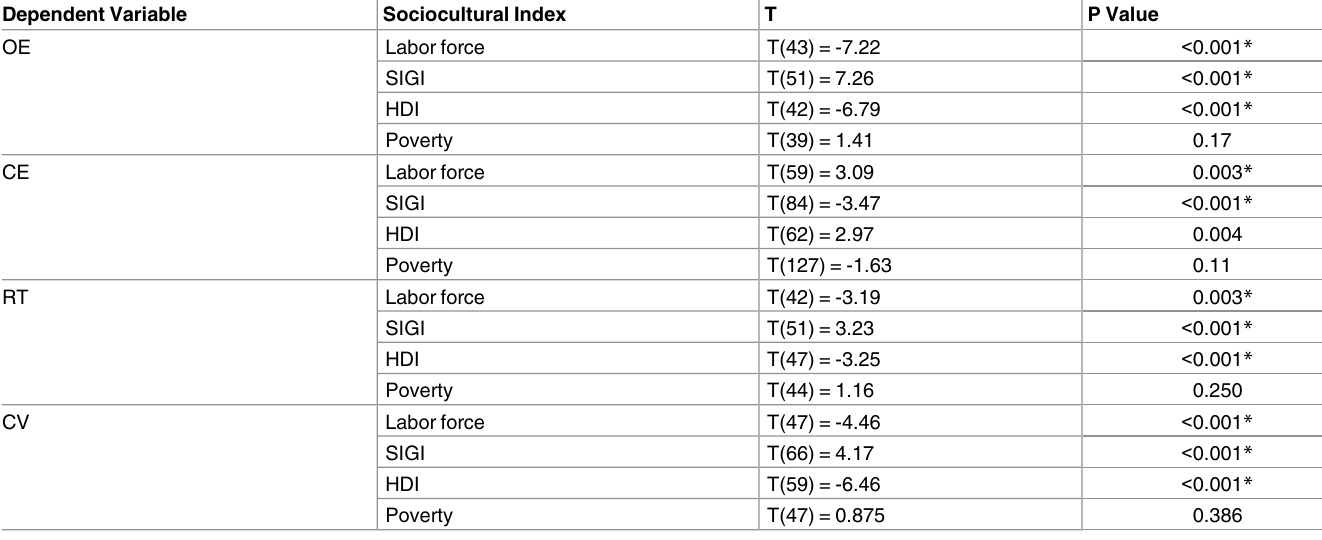
errors. Gender inequality accounted for a 1–2.5% change in error rates. Correlation analyses using socioculturalindices. To further confirm that the sociocul- tural indices were correlated with the size of gender difference, we performed Pearson’s corre- lation analysis between the average gender difference in each country and each of the 4 indices. For these analyses we excluded a single country from which fewer than 20 women participated (total countries = 40, total N = 16,552). For CV and reaction time we found no significant cor- relation between the magnitude of gender difference and any indices of social conditions (all |r| < 0.35). However, consistent with the mixed model analysis above, for commission and omis- sion errors we found significant correlations (using the Bonferroni correction) between gender difference and indices of gender equality (Table 5, Fig 3). Specifically, we found that in condi- tions of lower gender equality, men made more commission errors and women made more omission errors, but as gender equality increased, men and women performed more similarly on both measures. These results, using country averages, supported the results of our mixed model analysis above. Table 3. Effects of sociocultural conditions on average (men and women together) gradCPT performance. Dependent